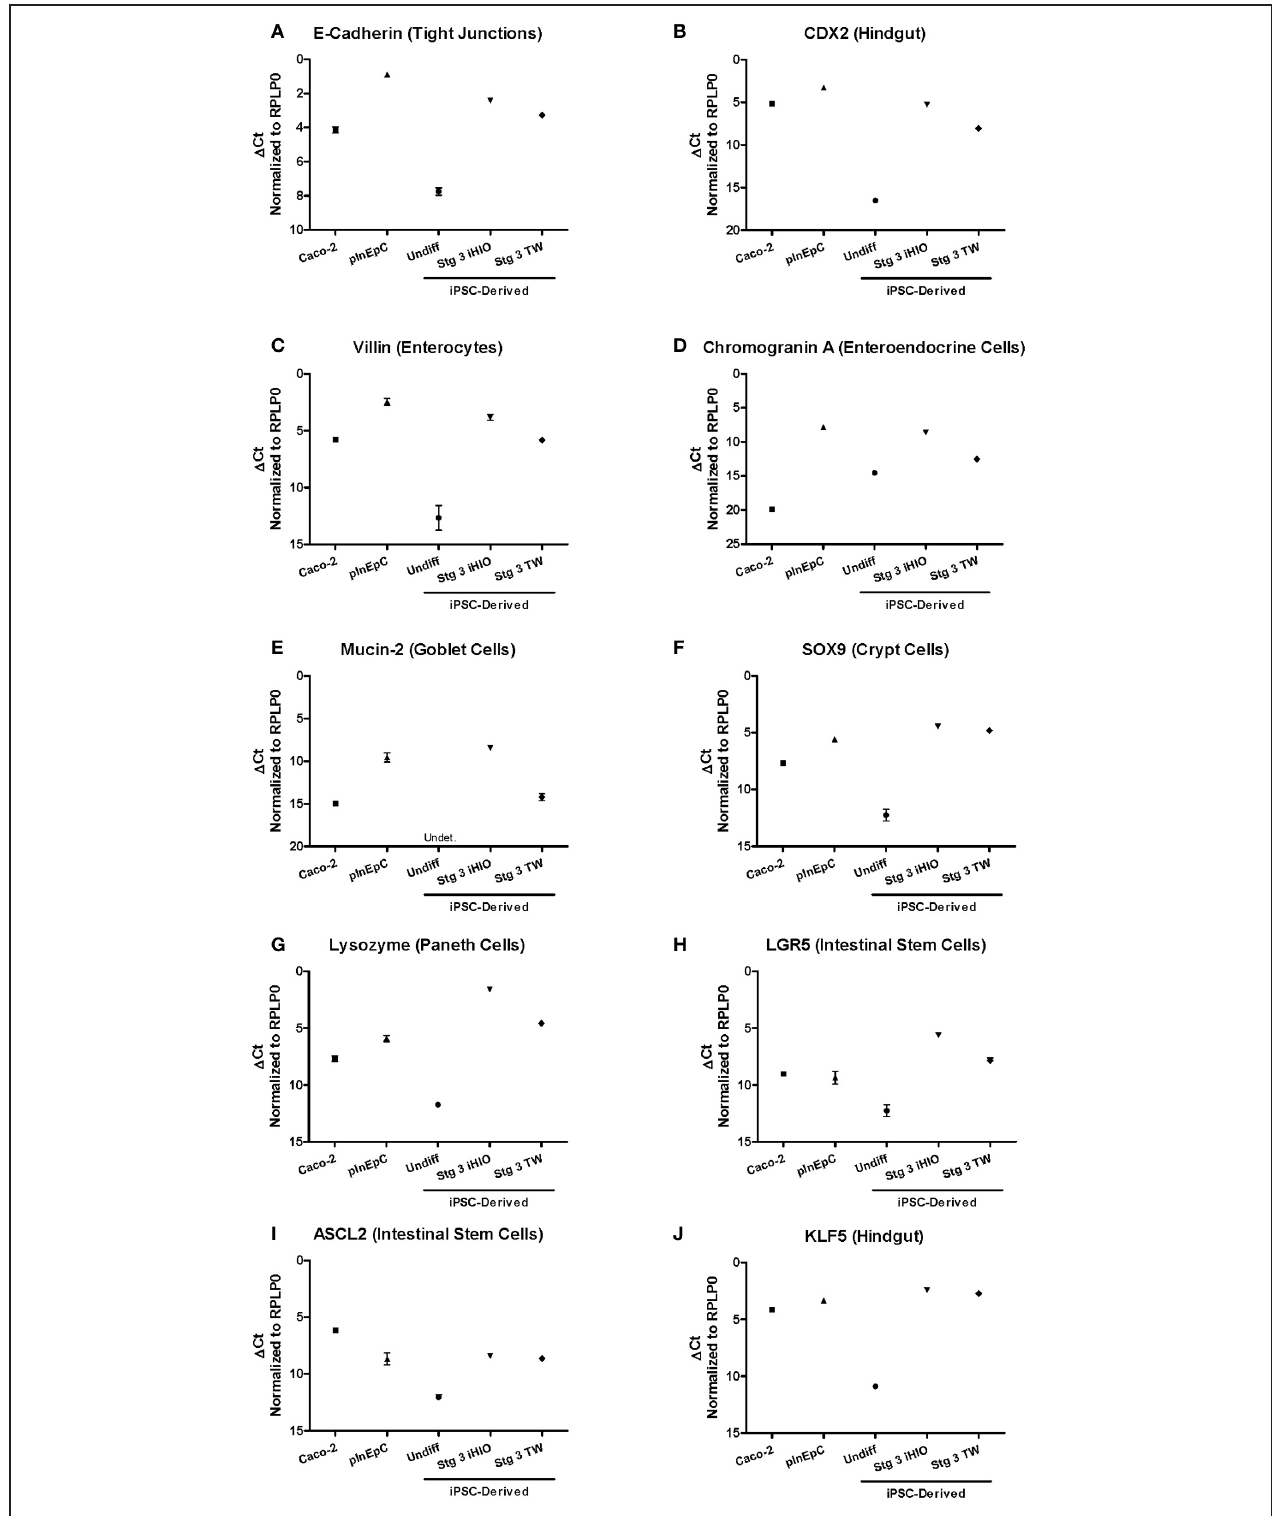
FIGURE 4 | Comparison of intestinal marker mRNA expression in multiple sources of human intestinal epithelial cells. Expression of tight junction marker (A) and hindgut epithelia (B) , as well as specific epithelial lineage markers (C–J) intestinal markers of epithelial intestinal lineages was evaluated by RT-PCR in Caco-2, primary hInEpCs (average